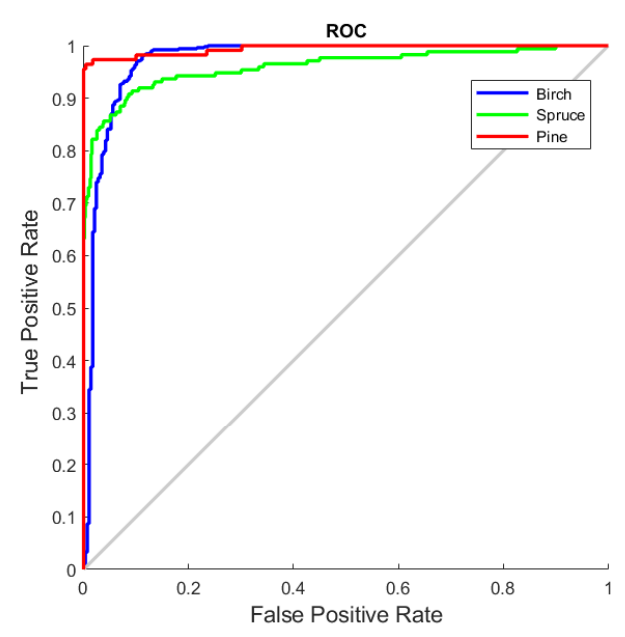
Figure 7. Receiver operative characteristic (ROC) curve of the feedforward network for all layers.